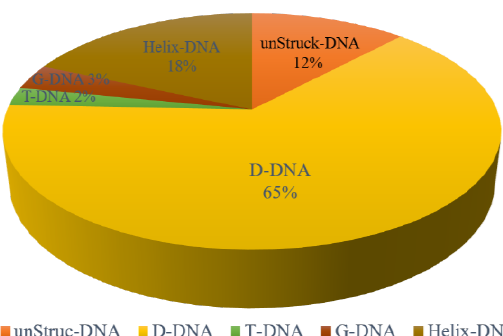
Figure 9. The proportion of five classes of DNA structures in PDB. The 5 classes include unStruck- DNA (DNA without base pairs), Helix-DNA (DNA with pure duplex structure), D-DNA (DNA with both duplex and loop structures), T-DNA (DNAs containing triple helices), and G-DNA (DNAs containing quadruple helices or consecutive stacking G-quadruples).